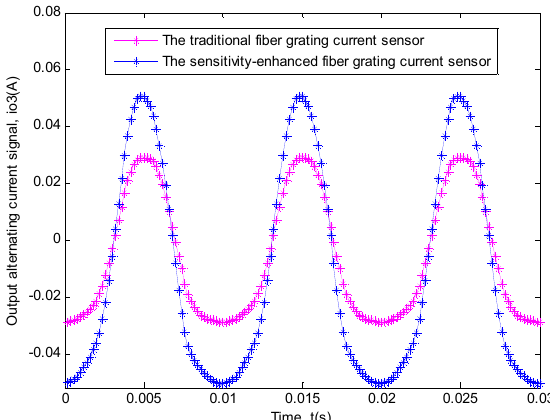
Figure 12. This experiment result of the two sensors between output alternating current signal ( i o 3 ) and time ( t ). The blue curve shows the relationship of the sensitivity-enhanced fiber grating current sensor. The magenta curve shows the relationship of the traditional fiber grating current sensor.